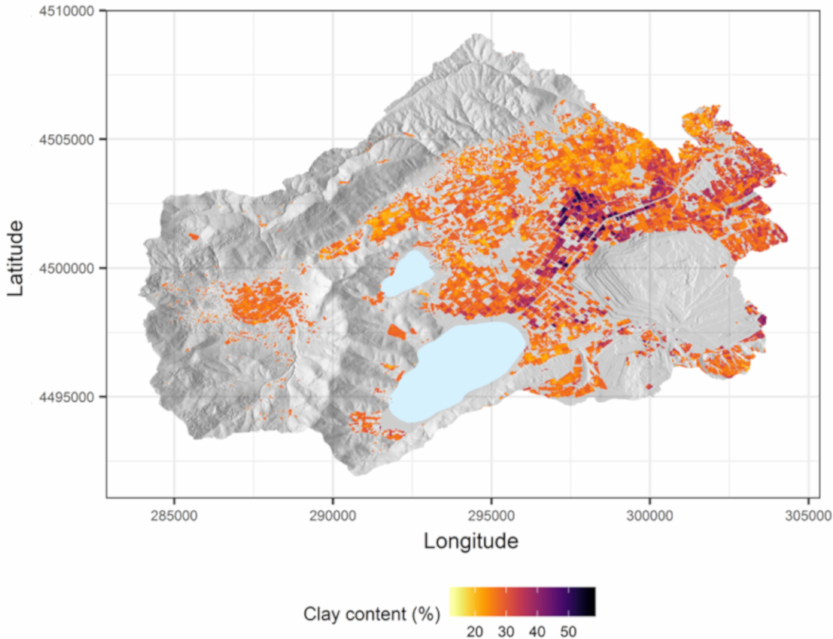
Figure 13. Resulting clay content map illustrating the median parcel level as derived by the proposed CNN and the synergistic use of Sentinel-1and Sentinel-2